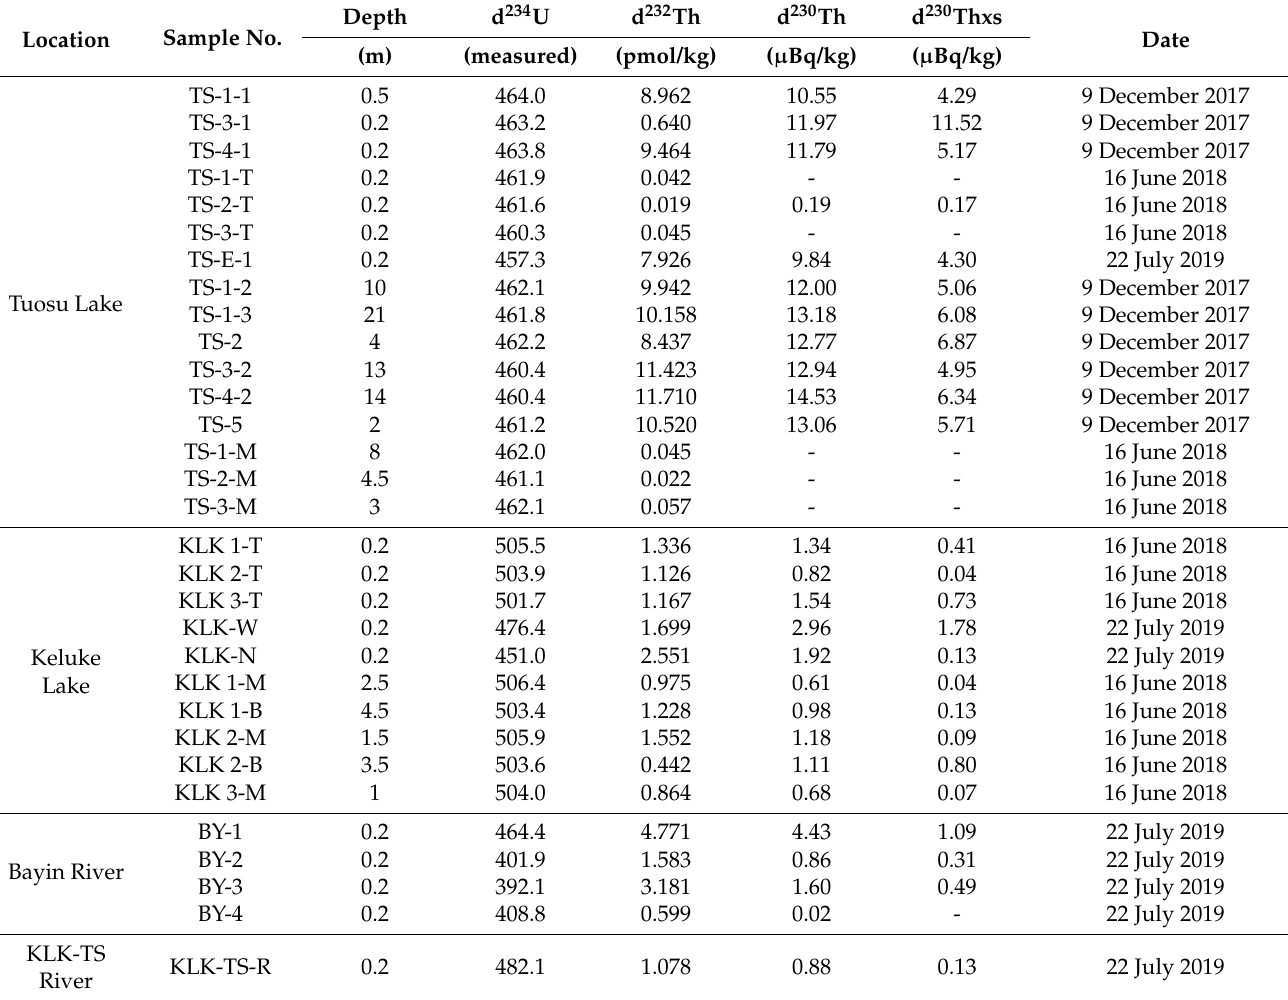
Table 2. The dissolved 232 Th, dissolved 230 Th and dissolved 230 Thxs concentrations in Tuosu Lake, Keluke Lake and